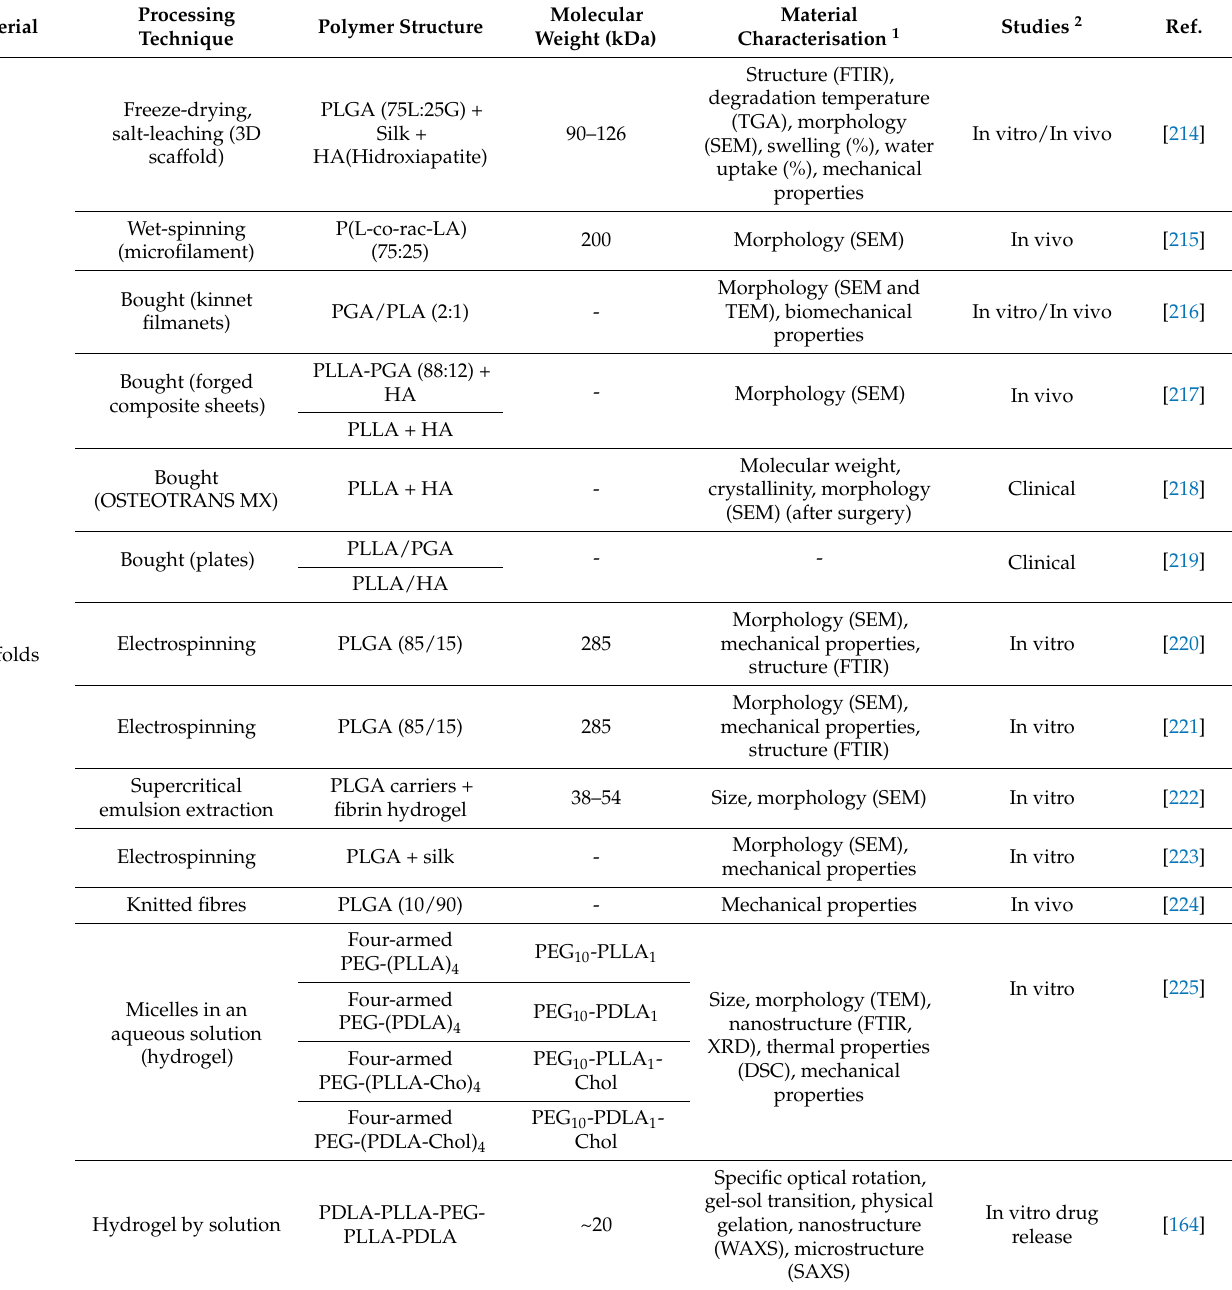
Table 4. Summary of PLA-derivative